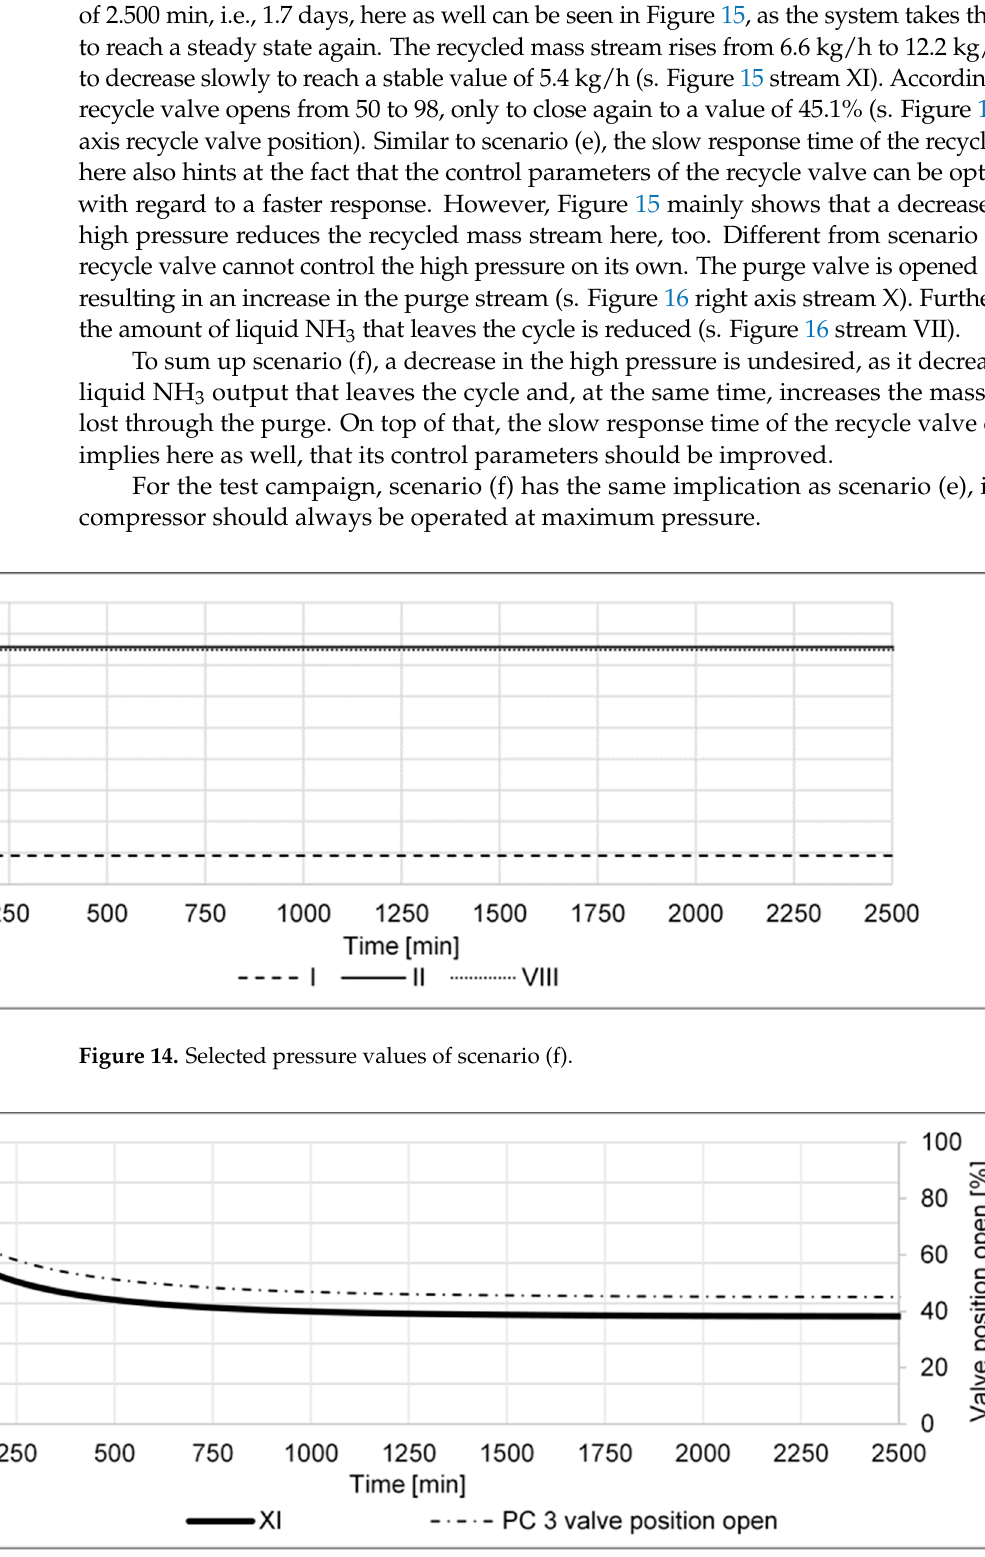
Figure 15. Recycle mass flow (left vertical axis) and position of the recycle valve (right vertical axis) of scenario (f).